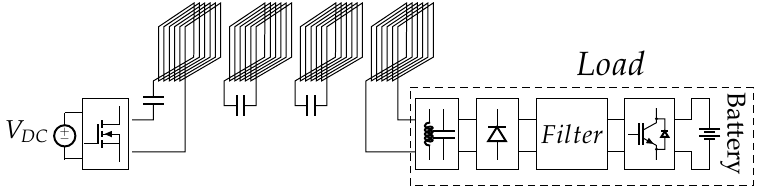
Figure 1. Array of R-L-C resonators as inductive coupling device of a battery